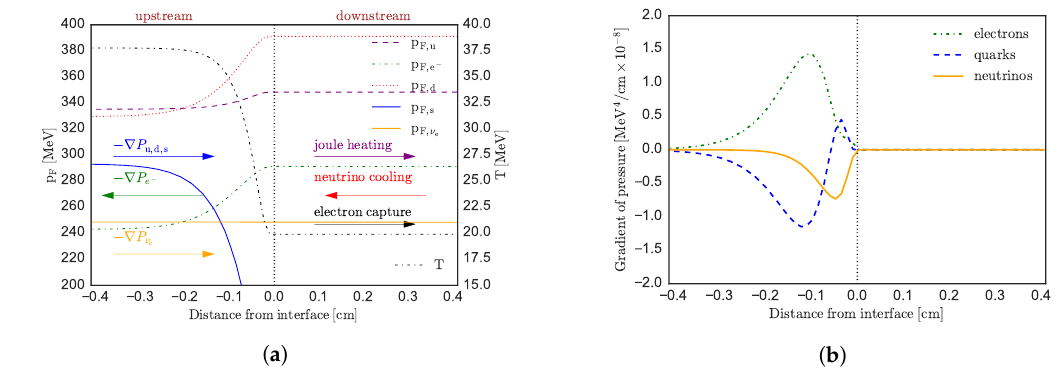
Figure 1. ( a ): Simulation snapshot of the burning interface. p F , i are the Fermi momenta for particles i , and T is the temperature. In both panels, the interface lies at position zero depicted by the vertical line. The arrows represent the directions of the force vectors and their labels depict the processes that caused them. Upstream is the side behind (left side of the vertical line) the interface, and downstream is the side in front of it (right side of the vertical line). ( b ): The pressure gradients for the leptons and quarks shown in Figure 1a. Figure and caption were taken from Paper II